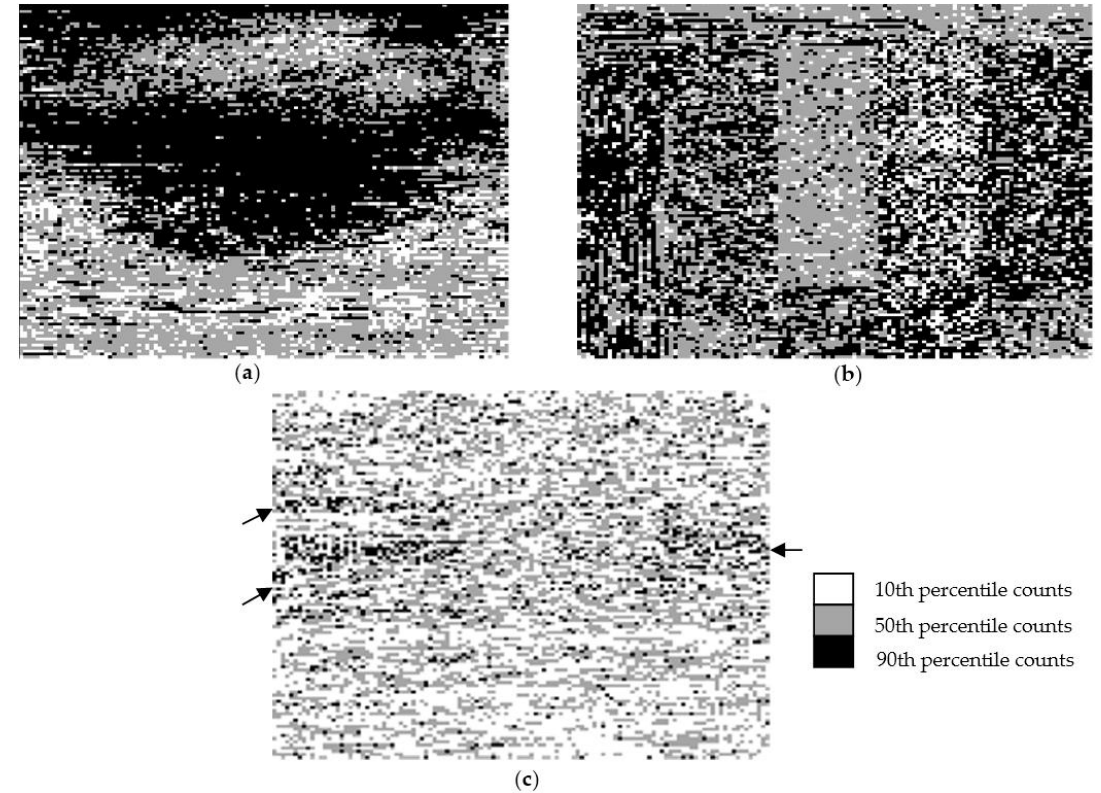
Figure 3. Two-dimensional heat maps representing the distribution of 10th percentile (white), 50th percentile (grey) and 90th percentile (black) counts in the total bacterial count data from each of the samples S1 ( a ), S2 ( b ) and S3 (( c ), arrows in black indicate the 90th percentile counts).